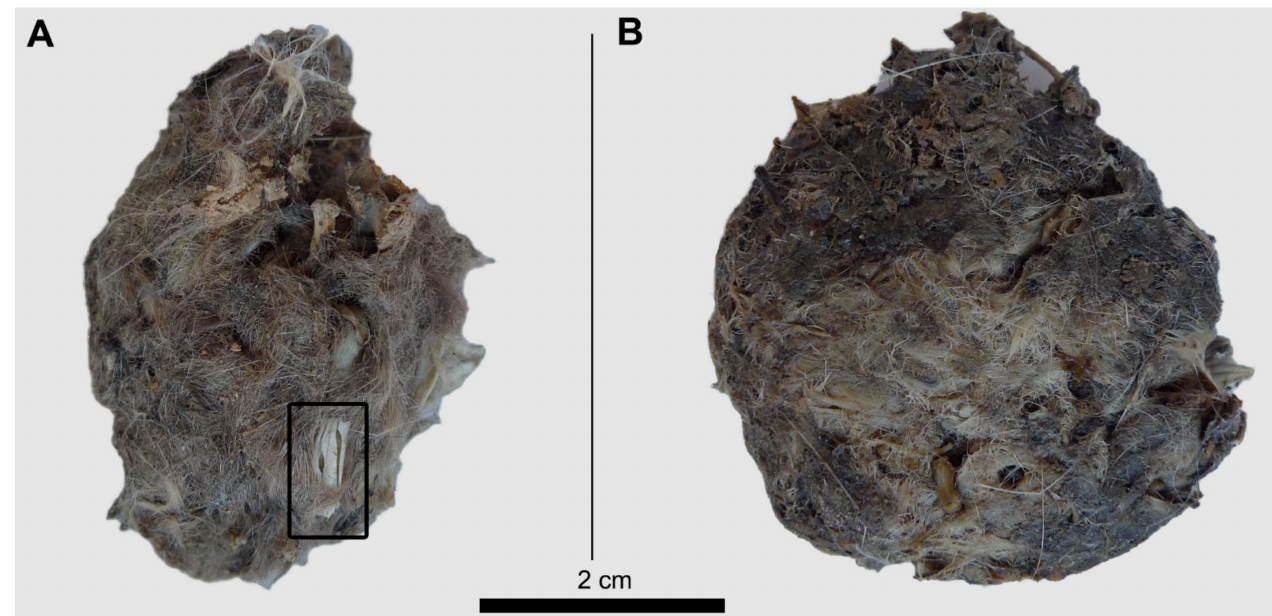
Figure 5. Barn owl pellets compressed under 500 N of force. ( A ) Dry pellet; ( B ) Wet pellet. The square in Figure A shows breakage as result of compression of a long bone (tibia) exposed on the pellet